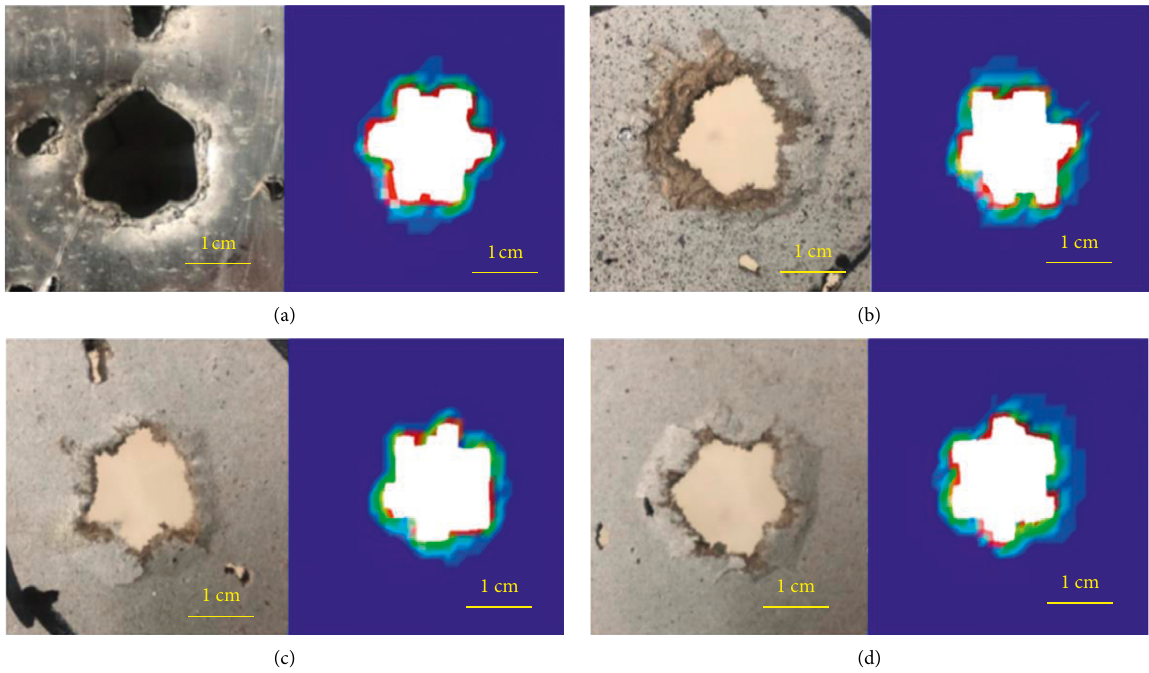
Figure 14: Comparison between experimental and simulation results: (a) first layer, (b) second layer, (c) third layer, and (d) fourth